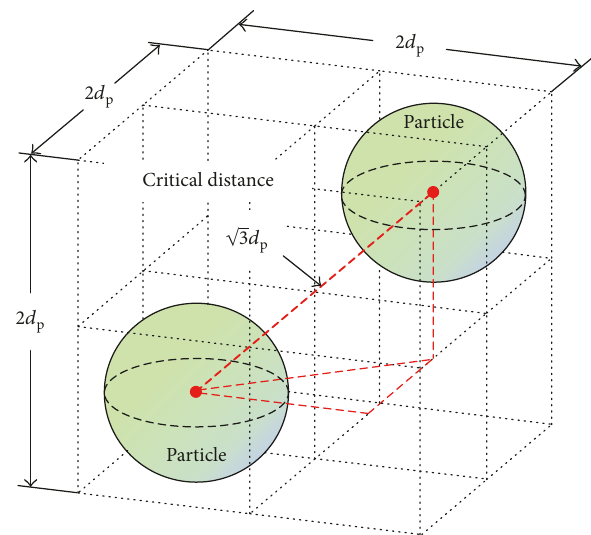
Figure 13: Critical distance to determine the CN. V 𝑡 but rather maintained a c did not change sharply with steady value over an extended time. For example, V c = 11.85 mm/s from 𝑡 = 1.5 s to 6.5 s under this